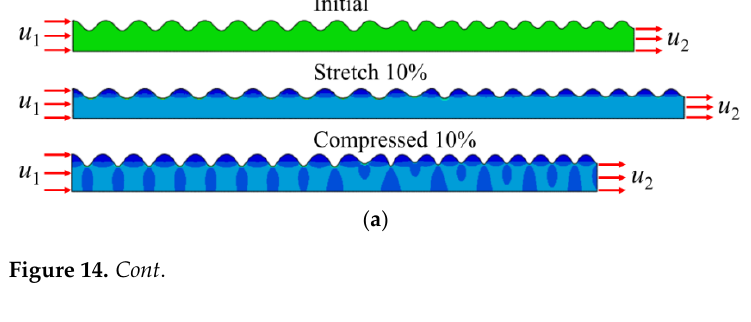
Figure 13. Influence of a 5% external load on the system: ( a ) deformation under a 5% tensile and compressive load; ( b ) transmission characteristic curve.